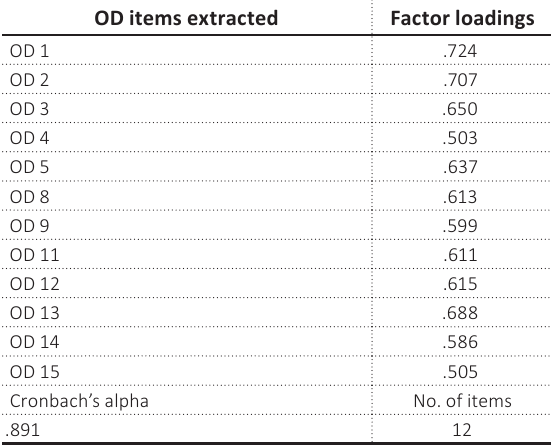
Table 1. Sampling adequacy